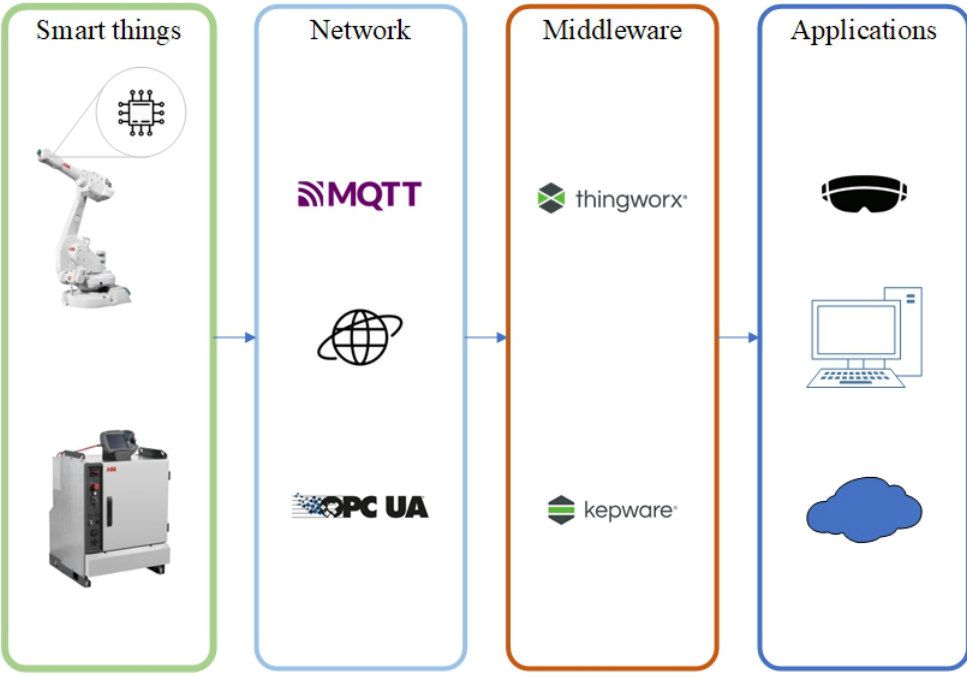
Figure 2. The frame of our proposed IoT